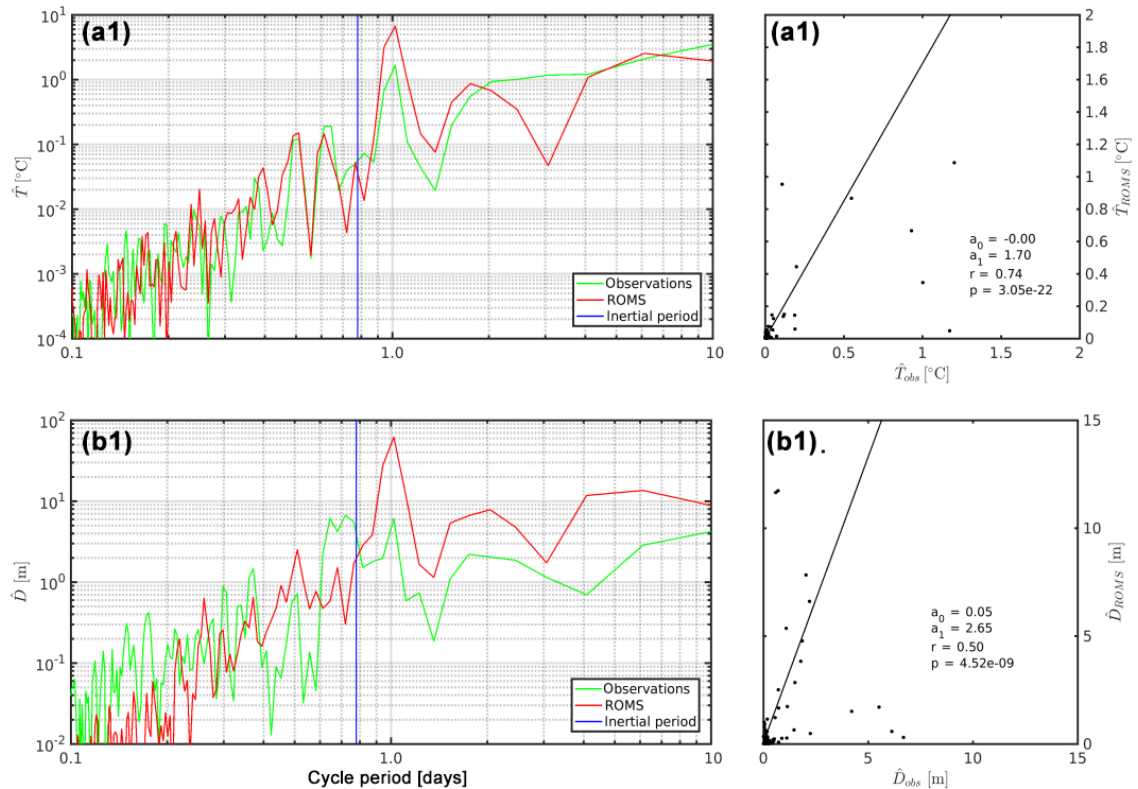
Figure 21. The spectra and correlation parameters of the modelled and observed amplitudes (a) ˆ T of the near-surface temperature at 0.81m of depth from run E4 and (b) ˆ D of the mixed-layer depth from run E9. The spectra were evaluated for the entire time series during 8–20 June where observations were